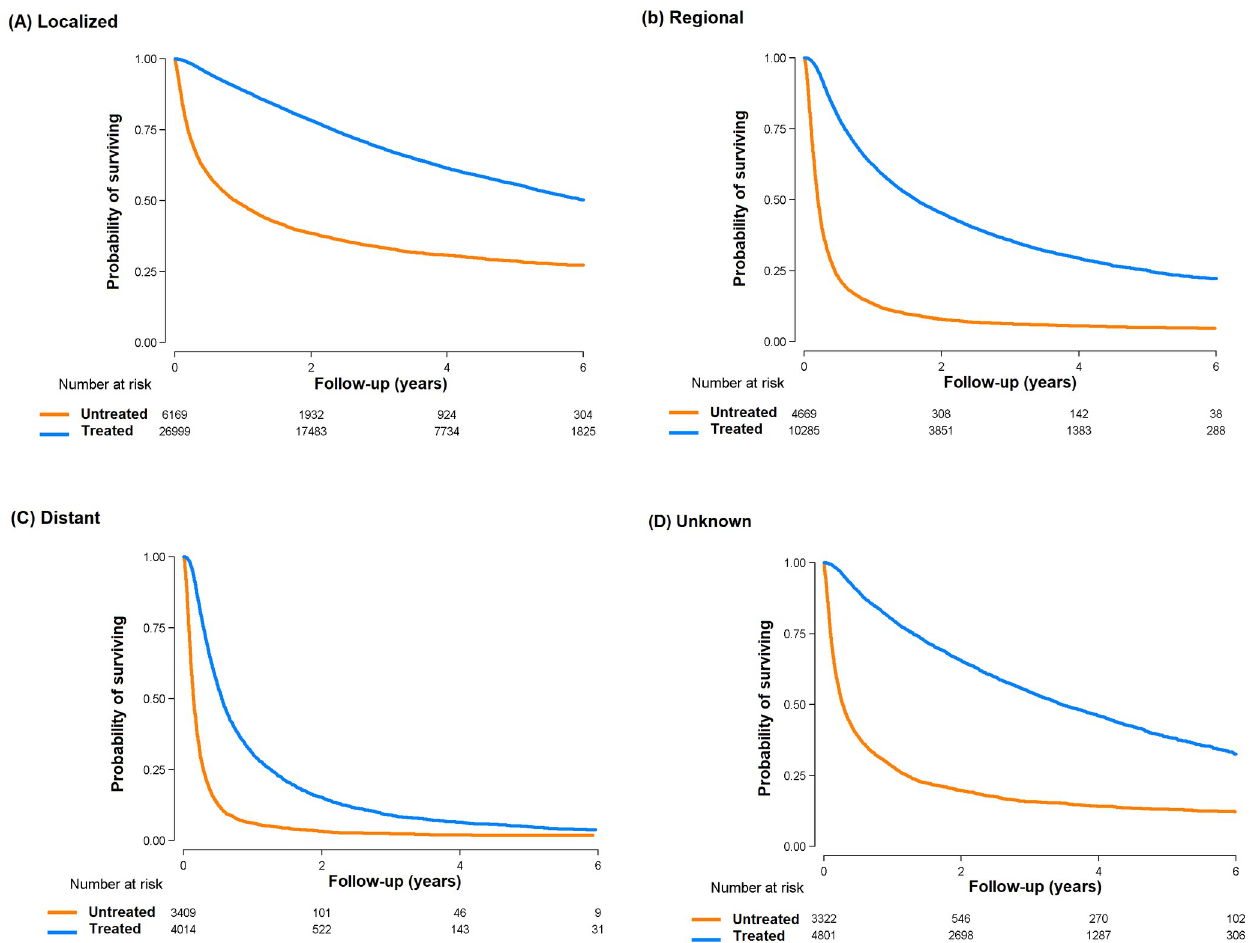
Fig 3. Overall survival from diagnosis of hepatocellular carcinoma by treatment status in subgroups of Surveillance, Epidemiology, and End Results (SEER) stage. (a) Localized disease; (b) Regional disease; (c) Distant disease; (d) Unknown.